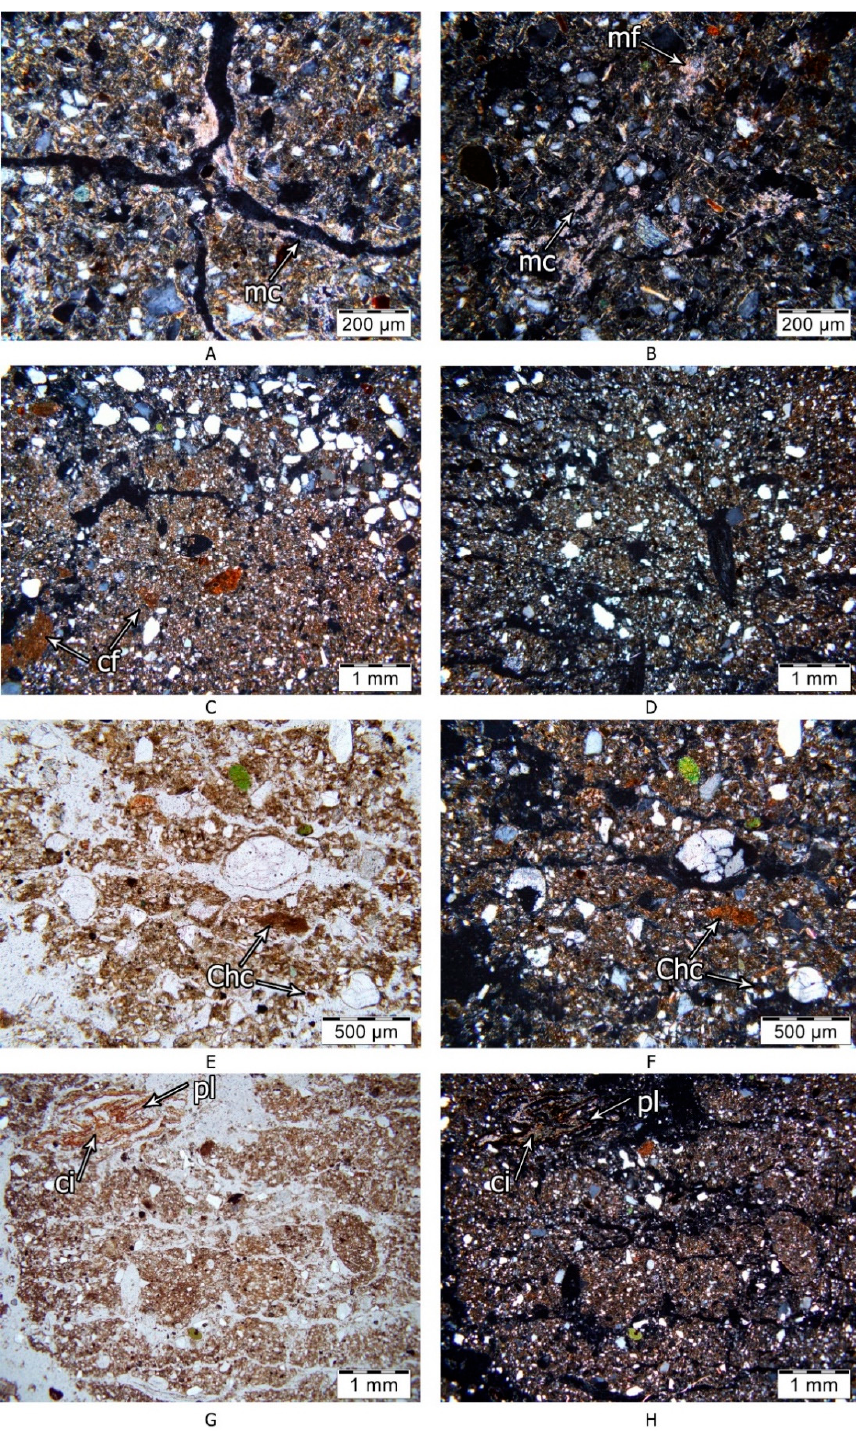
Figure 9. The microstructure of Mollic and Cambic horizons of Kastanozem: ( A )—dense silty clay micromass with blocky aggregates, high birefringence, and thin micritic coatings (mc) (20–40 cm, XPL); ( B )—thin micritic coatings (mc) and infillings (mf) in the micromass (20–40 cm, XPL); ( C )—loose silty clay micromass with sand streaks and abundant clay fragments (cf) of various shapes (9–20 cm, XPL); ( D )—transformation of rounded biogenic aggregates into thin platy aggregates and circular orientation (0–9 cm, XPL); ( E , F )—loose silty-clay-humus micromass with sand grains and fine granular and platy microstructure. With rare fragments of Chocolate clays (Chc) (0–9 cm, e–PPL; f–XPL); ( G ), ( H )—carbonate impregnation (ci) within plant (pl)tissue (0–9 cm, g–PPL;